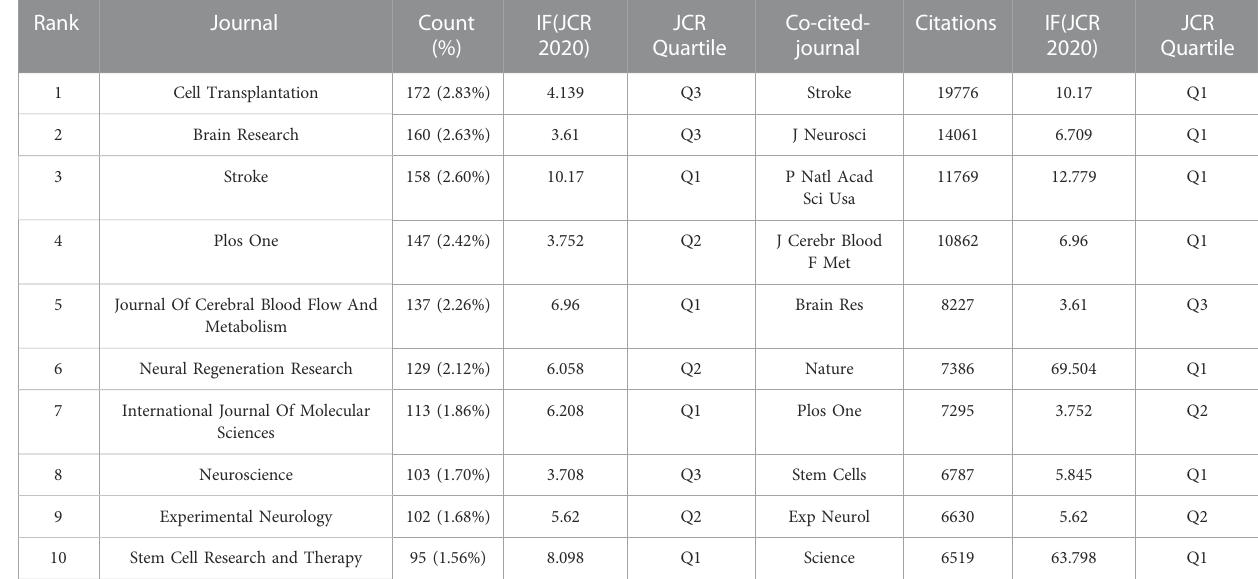
TABLE 4 Top 10 journals and co-cited journals related to stem cells in stroke.